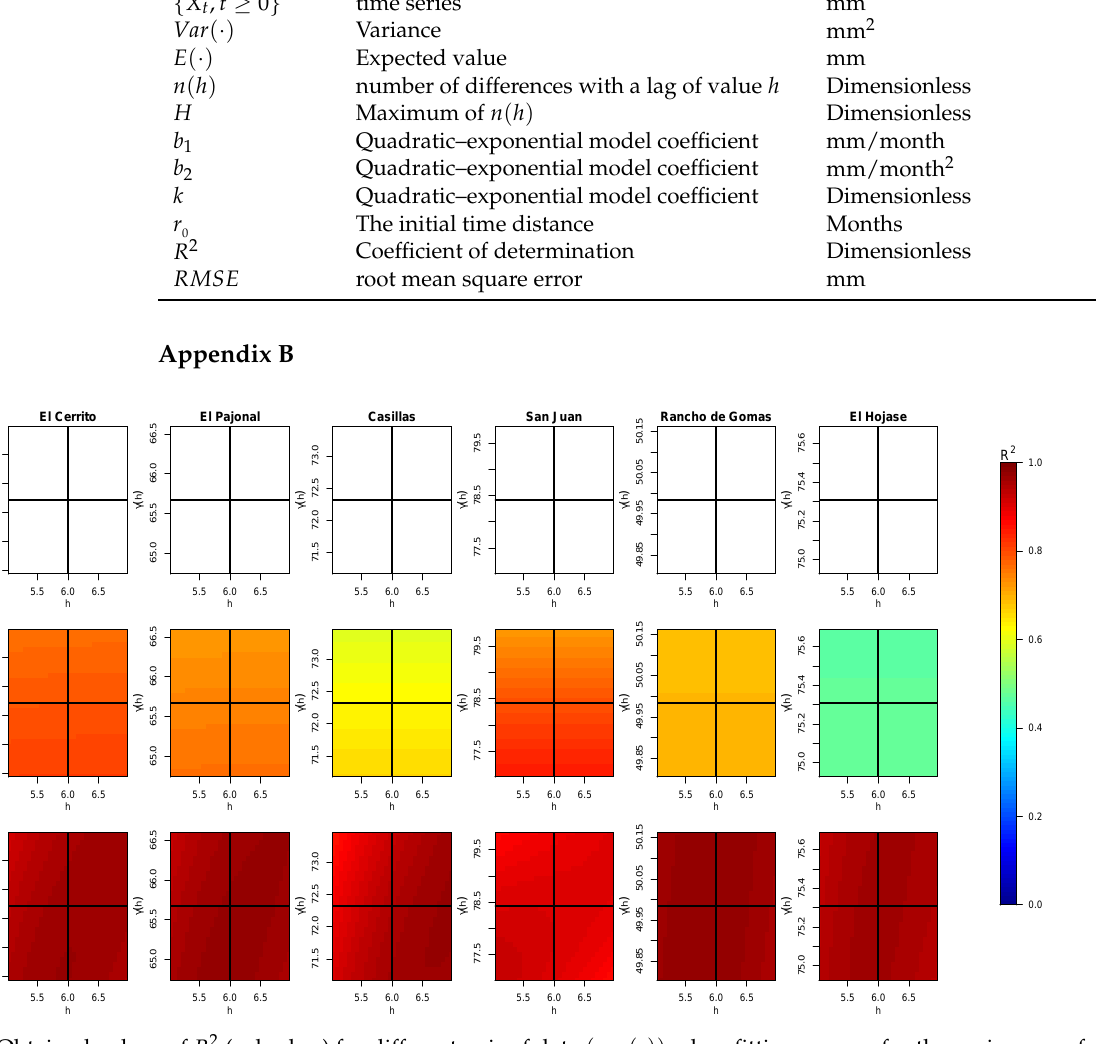
Figure A1. Obtained values of R 2 (color bar) for different pair of data ( r , γ ( r )) when fitting a curve for the variogram of each station with the three models and without considering the nugget effect. The intersection of the black solid lines tags the real position ( r , γ ( r )) in our experimental variogram. The white areas correspond to lower values than those shown on the color scale, i.e., lower than